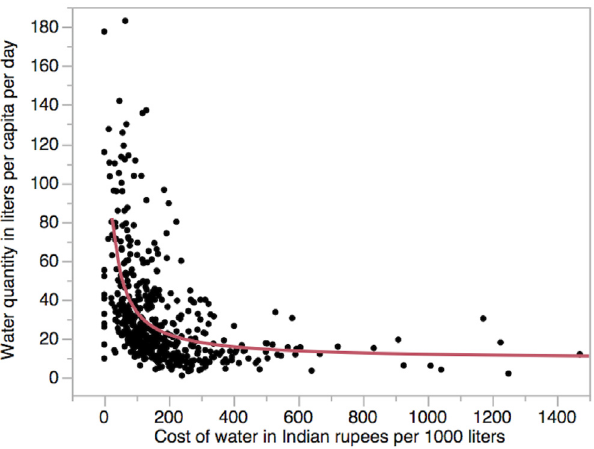
Fig 4. The relationship between price of water and quantity of water